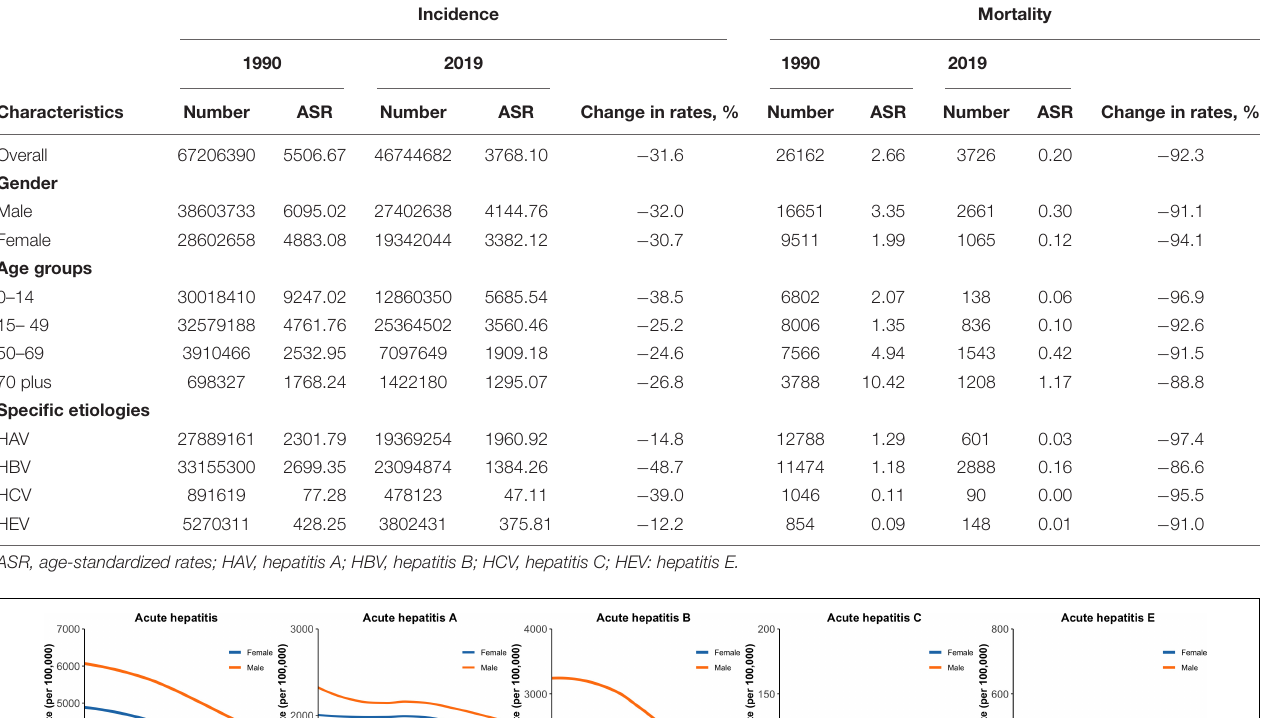
TABLE 1 | Change of incidence and mortality for viral hepatitis between 1990 and 2019 in China.